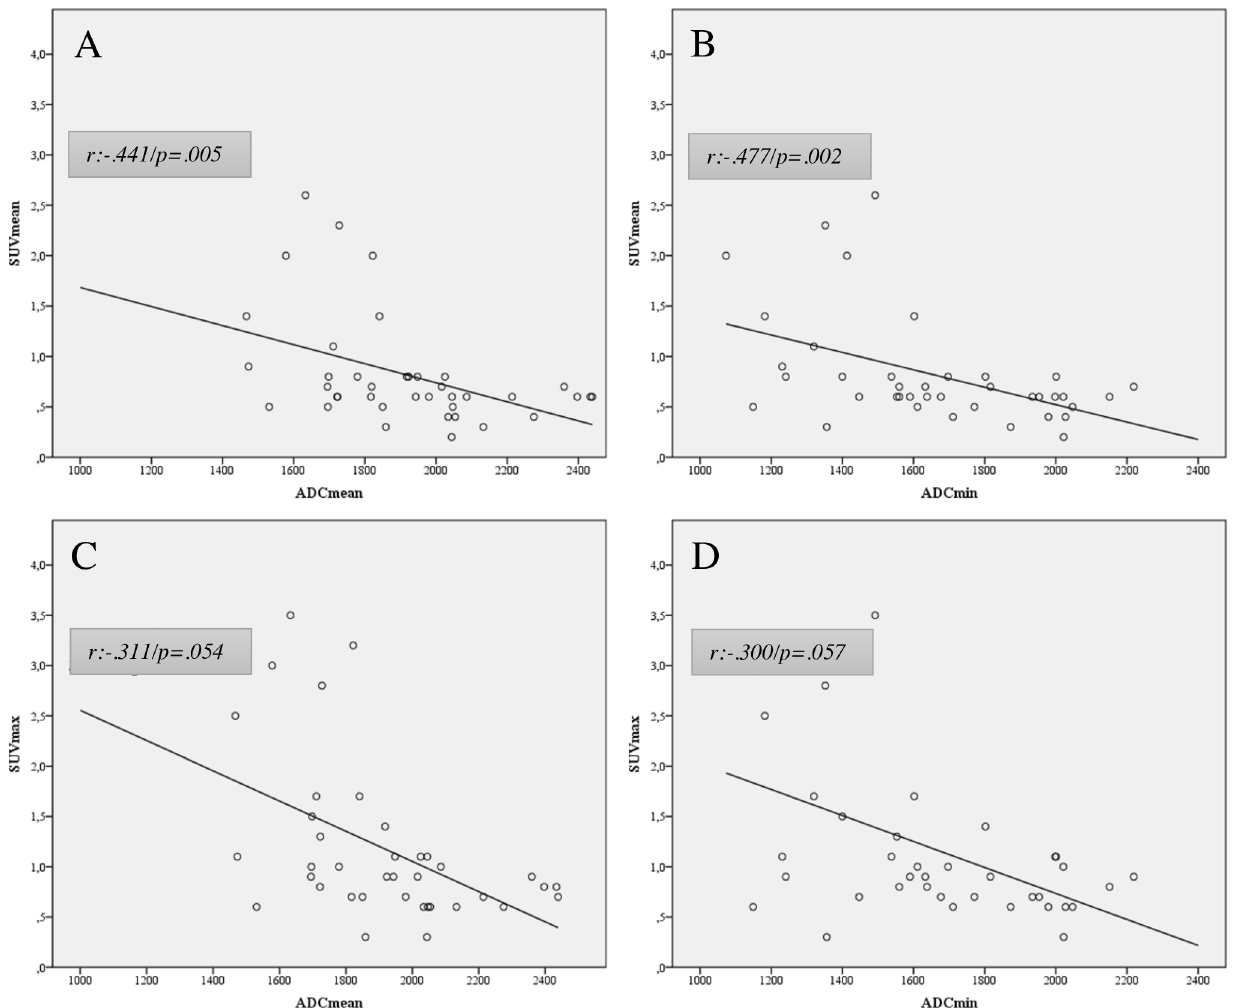
Fig 1. Correlation of glucose metabolism and cell density in PET/MRI. (A and B) SUVmeanshoweda moderate, inverse correlationto ADC mean and min. (C and D) SUVmax showeda weak inversecorrelationfor and ADC mean and min.